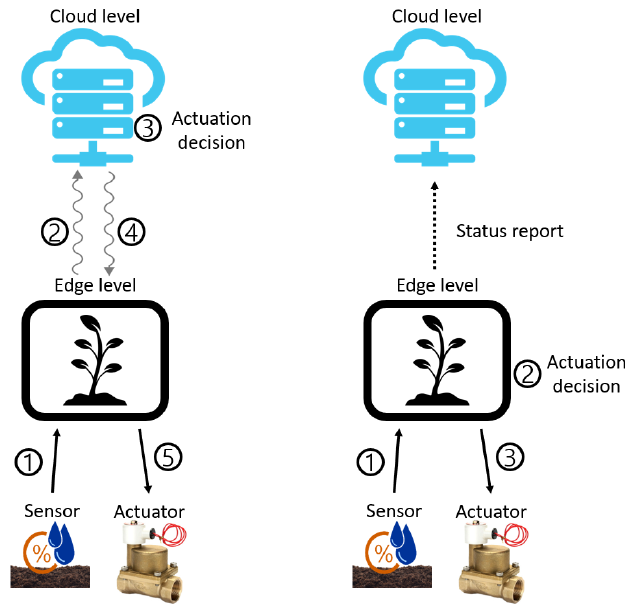
Figure 3. Closed-loop system at the cloud level vs. edge level.